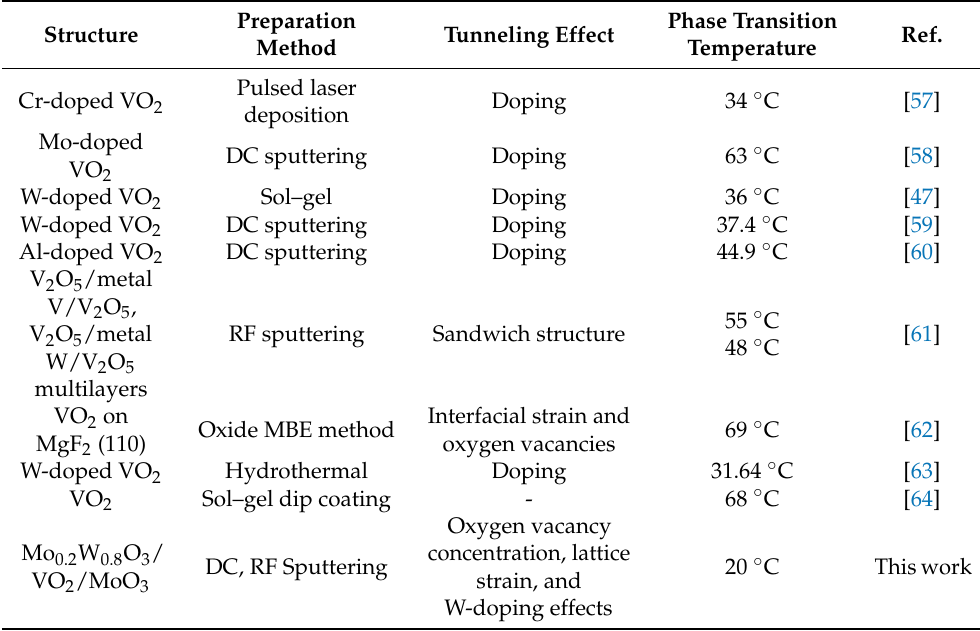
Table 4. Summary of the previous studies and the advantages of our current study. Preparation Structure